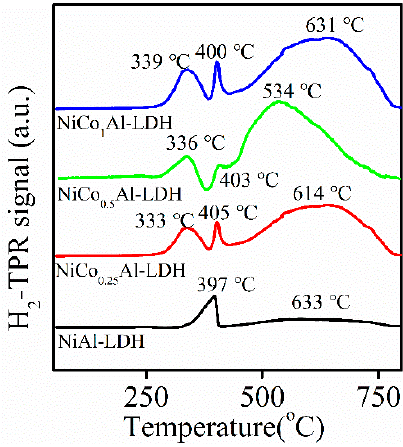
Figure 4. H 2 -TPR profiles of the NiCo x Al-LDHs.